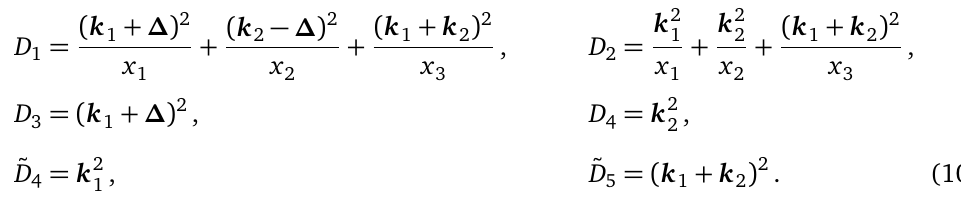
and k shifted 1 2